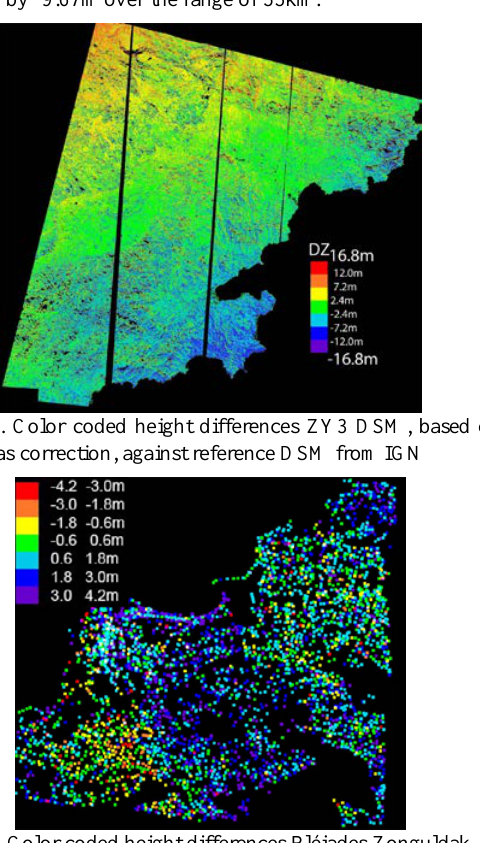
Figure 3. Color coded height differences Pléiades Zonguldak, orientation based on bias correction by affine transformation